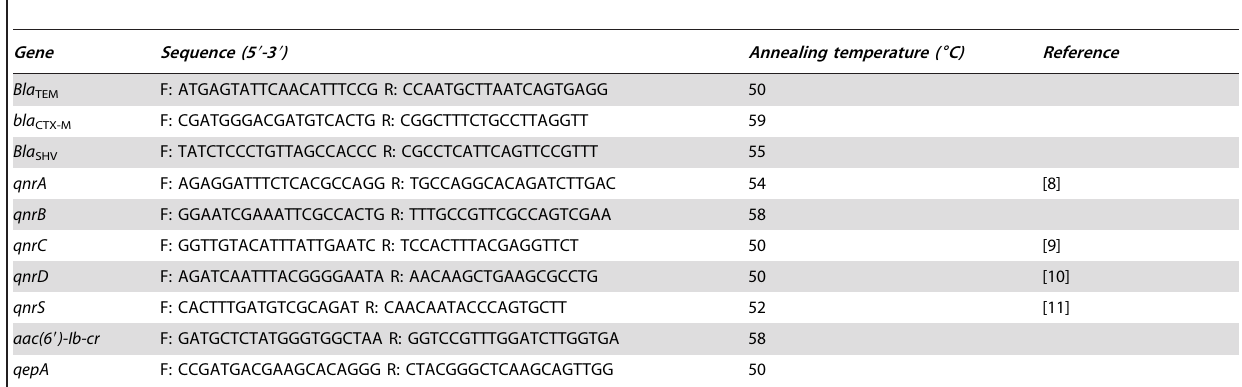
Table 1. PCR Primers and annealing temperatures.